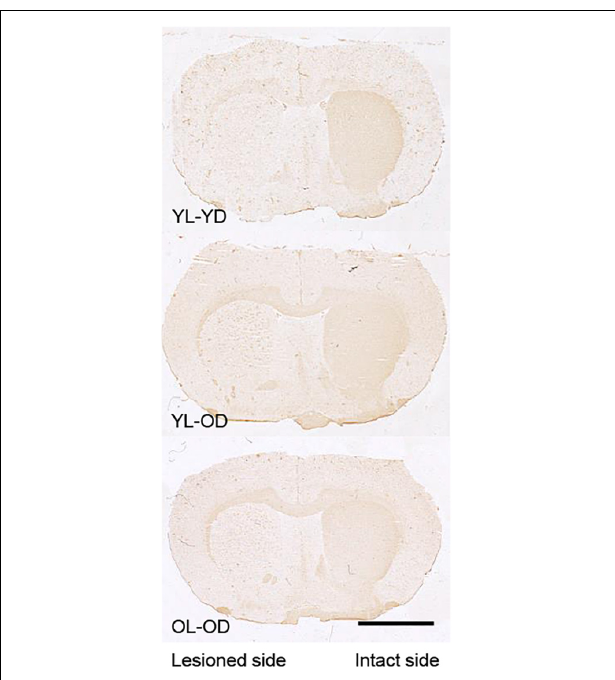
FIGURE 6 | Tyrosine hydroxylase immunohistochemistry in the striatal sections of 6-OHDA-lesioned and L -dopa-treated rats. The lesioned striatal side did not stain for tyrosine hydroxylase in any group. Scale bar, 3 mm. 6-OHDA, 6-hydroxydopamine; L -dopa, levo-dihydroxyphenylalanine; OL-OD, old-lesioned old- L -dopa group; YL-OD, young-lesioned old- L -dopa group; YL-YD, young-lesioned young- L -dopa